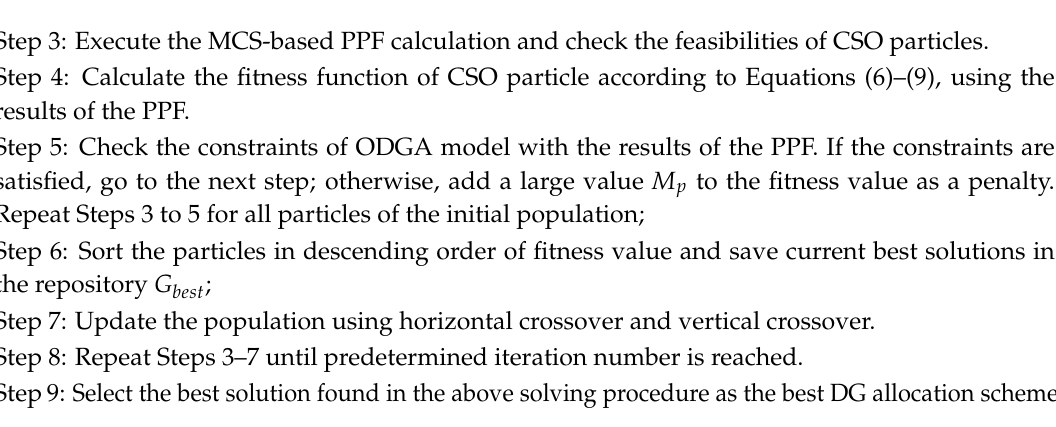
Figure 2. Flowchart of CSO ‐ MCS for solving the ODGA problem.